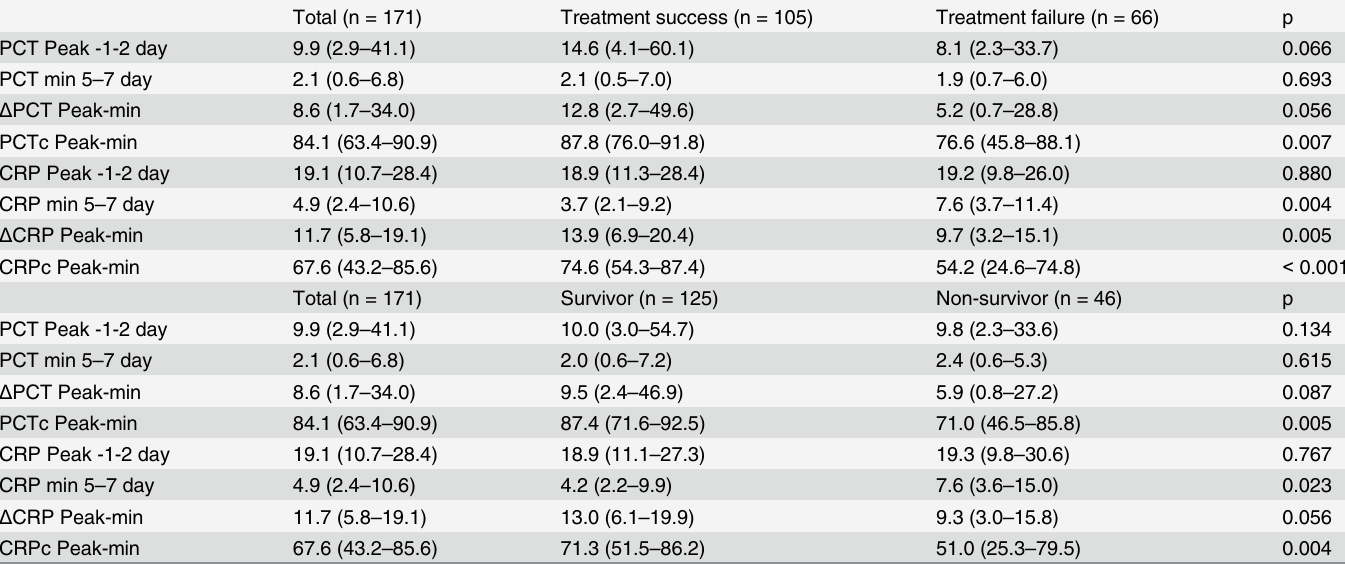
predicting treatment success. When we applied these two markers to predict the 28 day mortal- ity, they were significant marginally (0.05 < p -value < 0.10). However, we retain them in the model from the clinical consideration. Similarly, the adjusted AUCs for predicting 28 day mor- tality were 0.77 (0.66 – 0.88) and 0.77 (0.67 – 0.88) for PCTc and CRPc, respectively. However, there were no differences between the AUCs of PCTc and CRPc among treatment failure ( p = 0.531) and 28-day mortality, ( p = 0.553) (Fig 1). When both markers are used, the adjusted AUC rises to 0.79 (0.69 – 0.90) for 28 day mortality. However, when we factor others into the